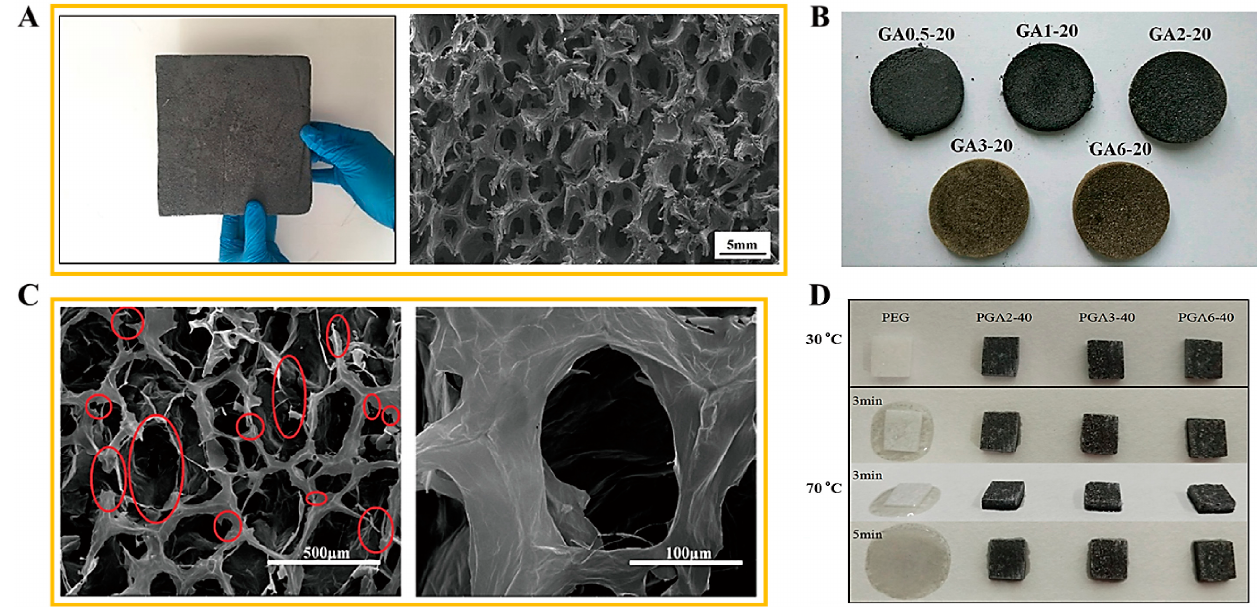
Figure 6. ( A ) graphene foam supported PCM composite, ( B ) GO/GNP aerogels with different concentration ratios, ( C ) SEM images of GO/GNP aerogel, and ( D ) photographs of pure PEG and PEG composite form.